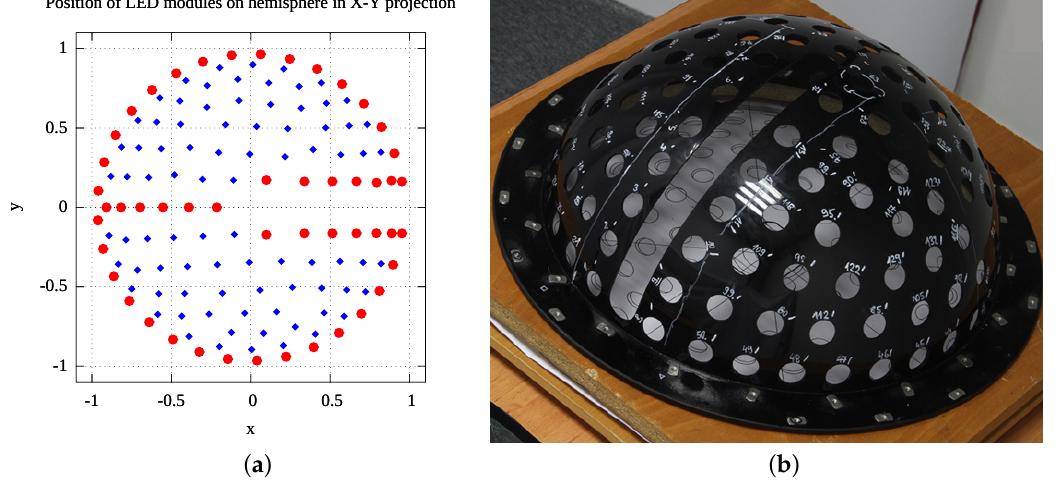
Figure 12. The distribution of 134 LED modules on the hemispherical skeleton. ( a ) the simulation model result shown projected onto an X-Y plane: bigger red points are for 50 deterministically set positions and 84 blue smaller points correspond to positions computed by randomised algorithm; ( b ) the manufactured skeleton from PMMA with holes for LED modules and slot for cameras. Note that 5 additional LEDs are mounted between the cameras and are not shown in this